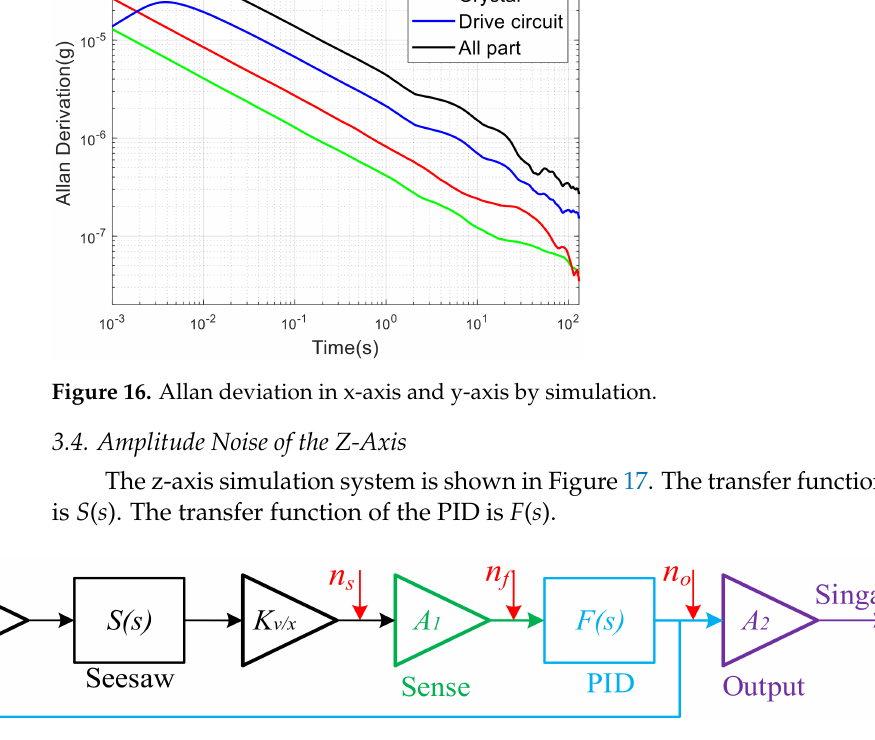
Figure 17. Simulation of phase noise in z-axis system.